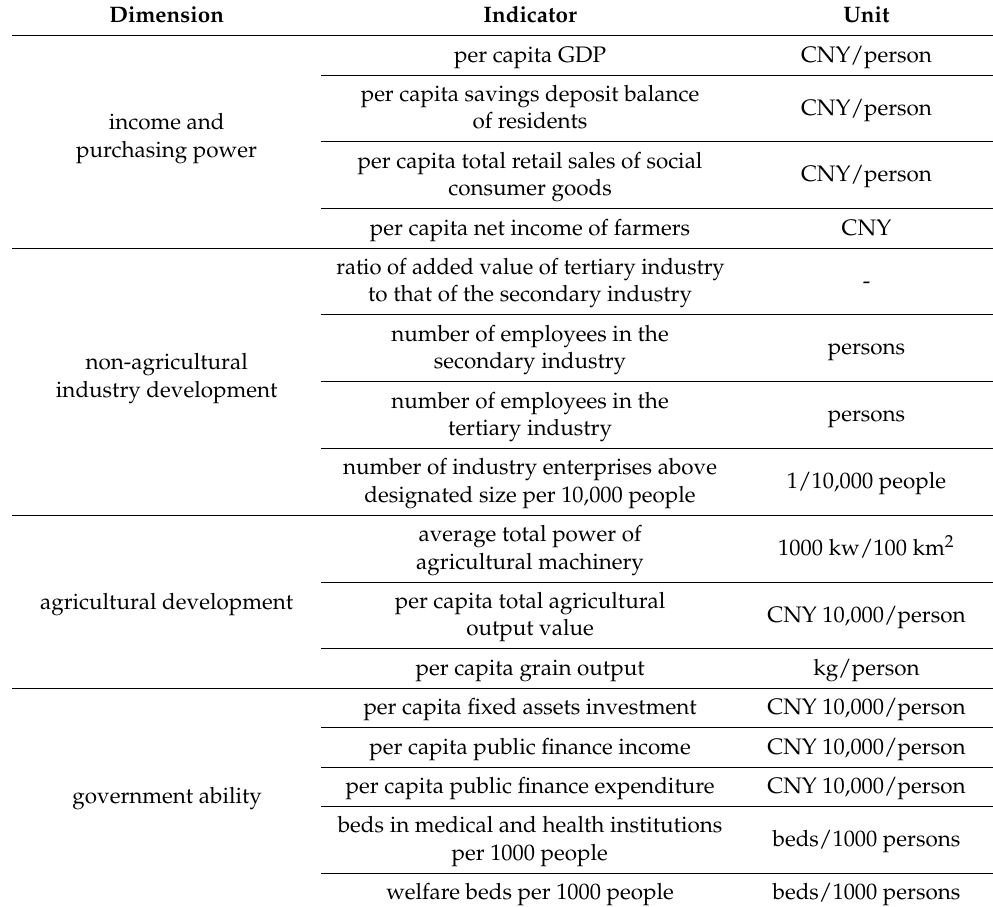
Table 1. Dimension and indicator of economic development level for